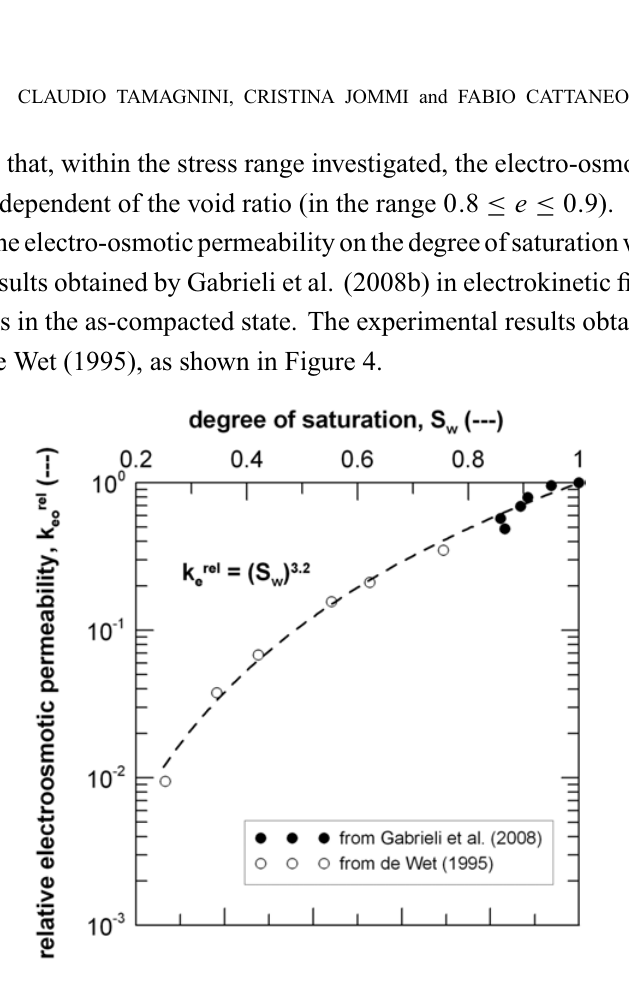
Fig. 4 – Relative electro-osmotic permeability: experimental data from de Wet (1995) and Gabrieli et al.